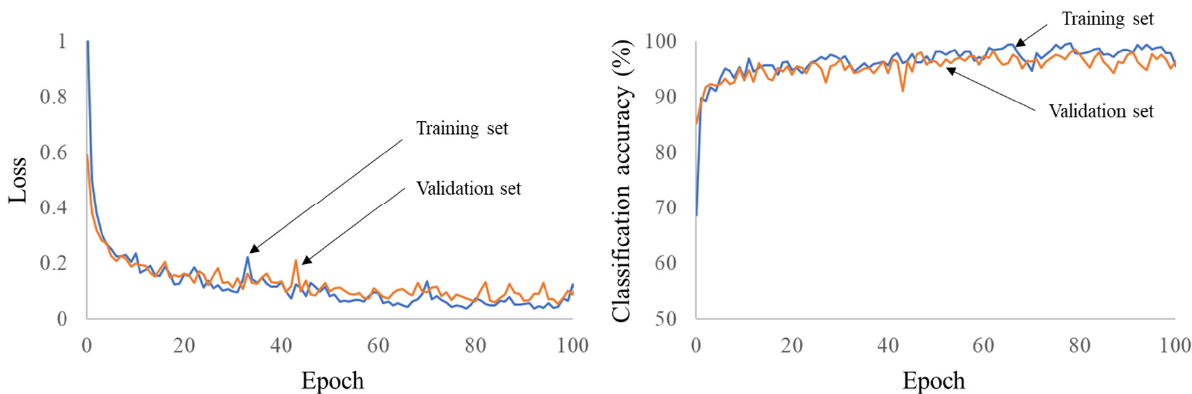
Figure 4. Total losses and classification accuracies for training and validation samples by epoch.